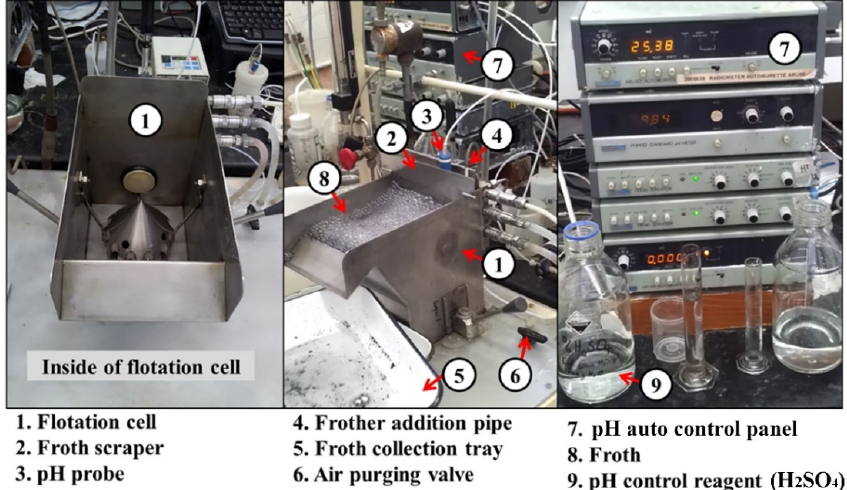
Figure 4. Laboratory-scale 3L stainless steel flotation cell used in this study.